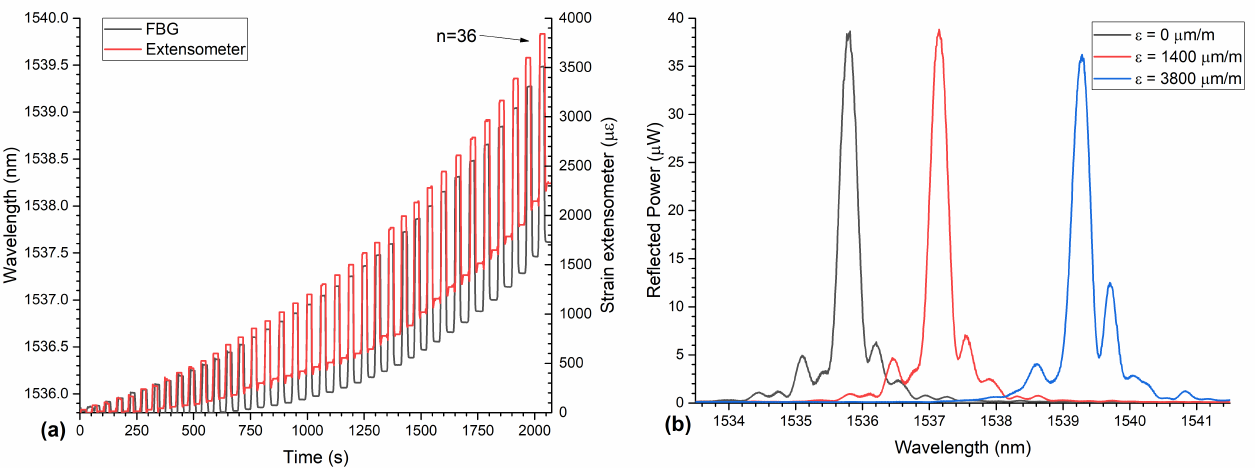
Figure 6. ( a ) The development of the Bragg-wavelength (here the data from the specimen with the Type-I FBG is shown as an example) and the strain as measured by the extensometer as functions of time during a tensile test experiment. The Bragg wavelengths are shown on the left axis and the strains on the right axis. The force each step was F n = n × 175N, with n as the number of the loaded step. After each step, force was reduced to zero again. ( b ) Spectra of the FBG during tensile tests at different applied strains. The first spectrum (black line) was captured at 0s, the second spectrum (red line) at 1160s, and the last spectrum (blue line) at